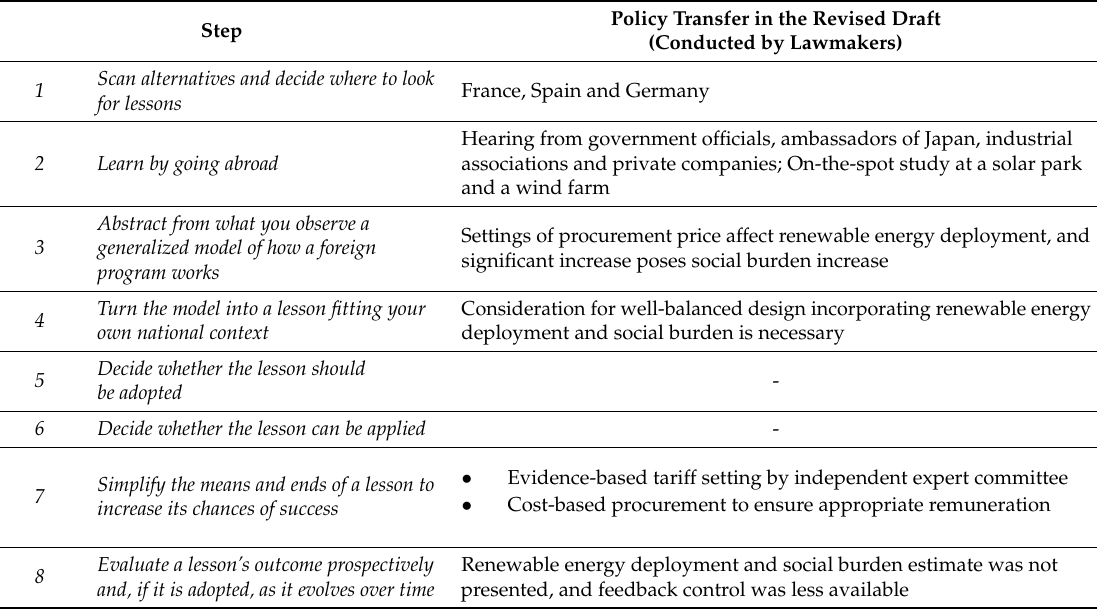
Table 6. An Assessment of the Policy Transfer by the